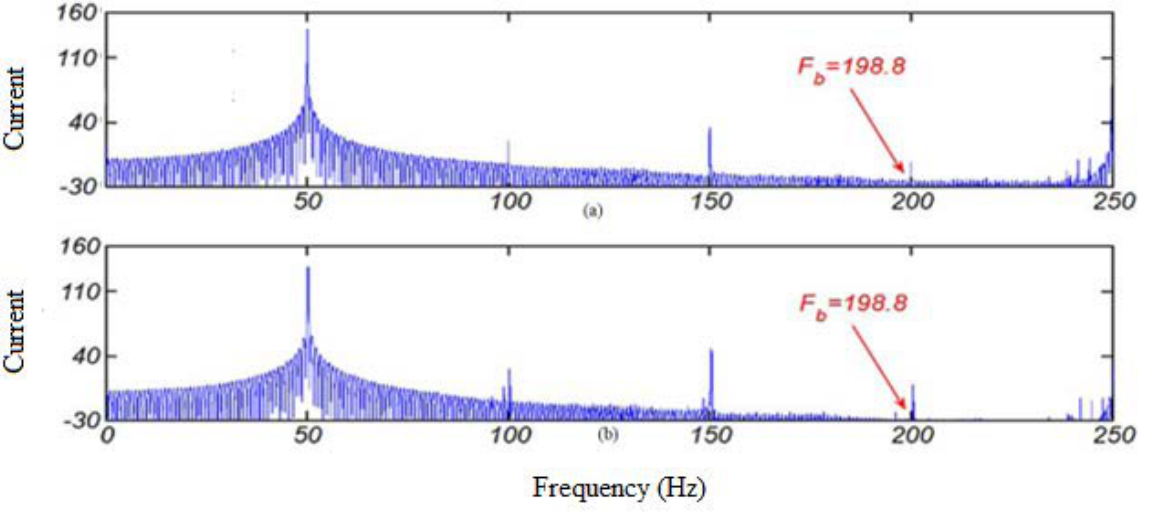
Figure 10. PSD of the stator current for bearings: ( a ) Healthy case; ( b ) outer raceway defect obtained from the instantaneous frequency of motor voltage